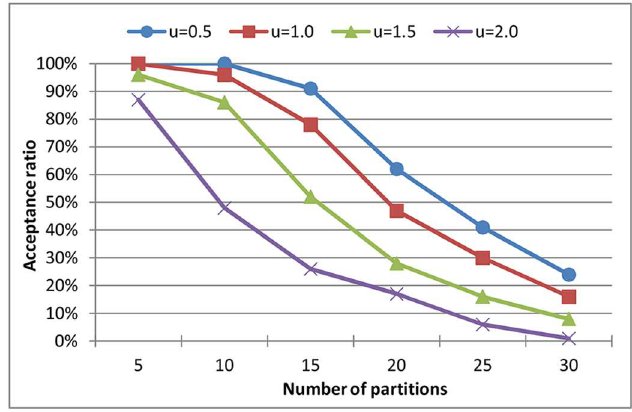
Fig 7. Acceptance ratios of our approach on partitions with harmonic